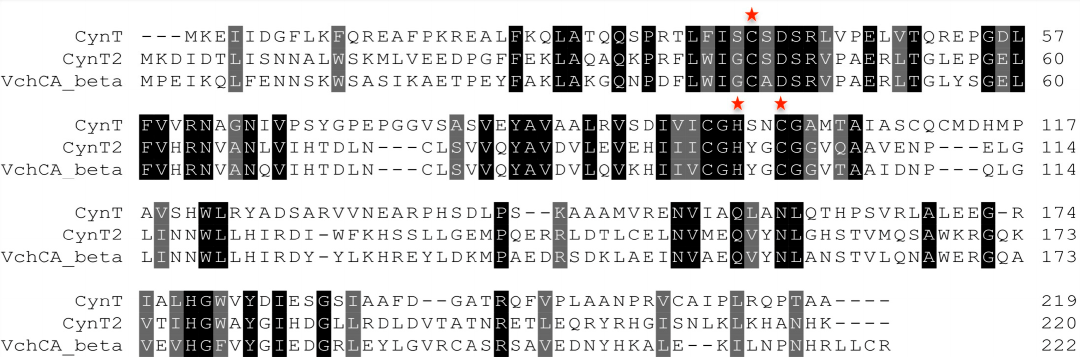
Figure 2. Multialignment of the two β -CAs (CynT and CynT2) from E. coli and the β -CA (VchCA_beta) from Vibrio cholerae . Legend: red stars indicate the metal ion coordinating residues. The alignment was formatted highlighting in black the identical residues and in gray the conservative substitutions. Multiple amino acid sequence alignment was performed with the program MUSCLE, version 3.7.